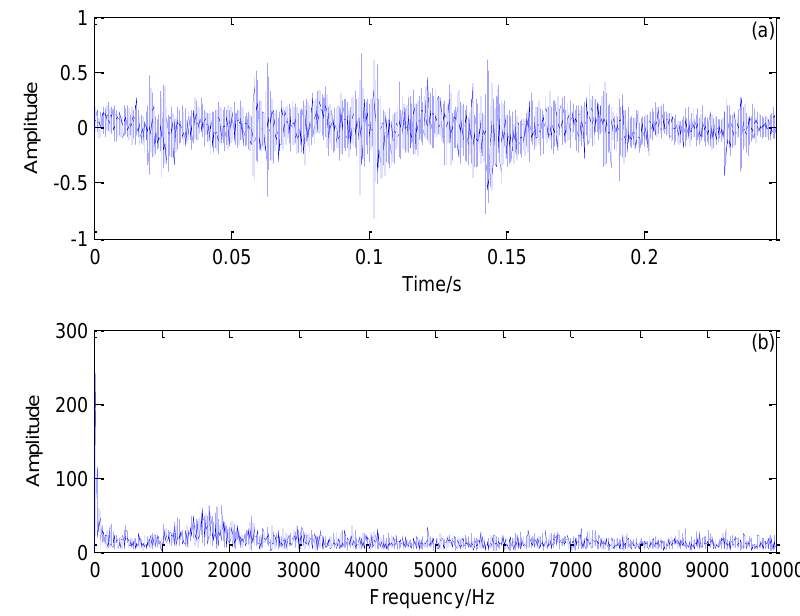
Figure 18. Inner race fault signal of the locomotive bearing: ( a ) time domain signal and ( b ) its